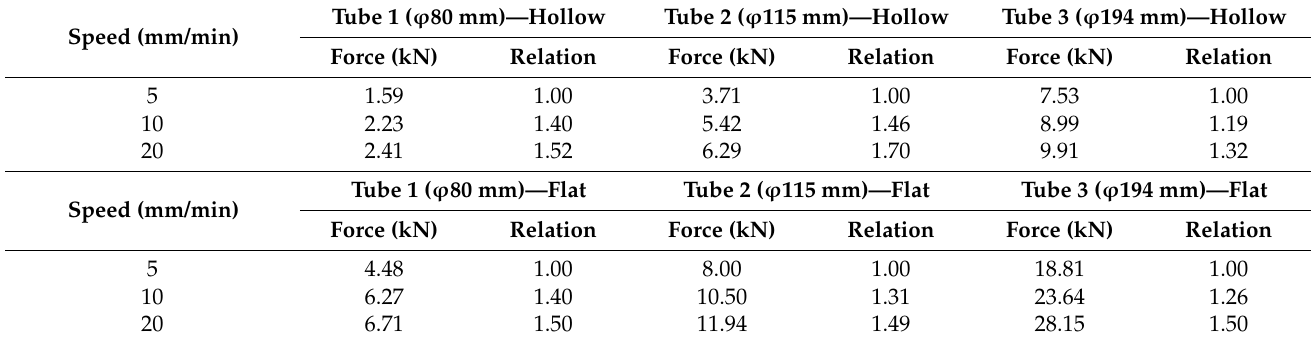
Table 5. Values of penetration force for all scale tests as a function of speed.